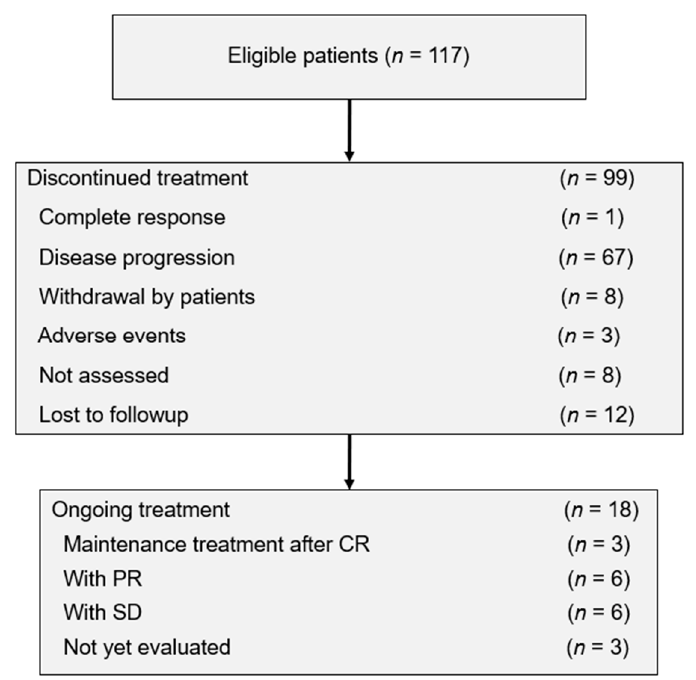
Figure 1. Patient disposition. CR, complete response; PR, partial response; SD, stable disease. Table 2. Tumor responses assessed by RECIST v.1.1 ( n =